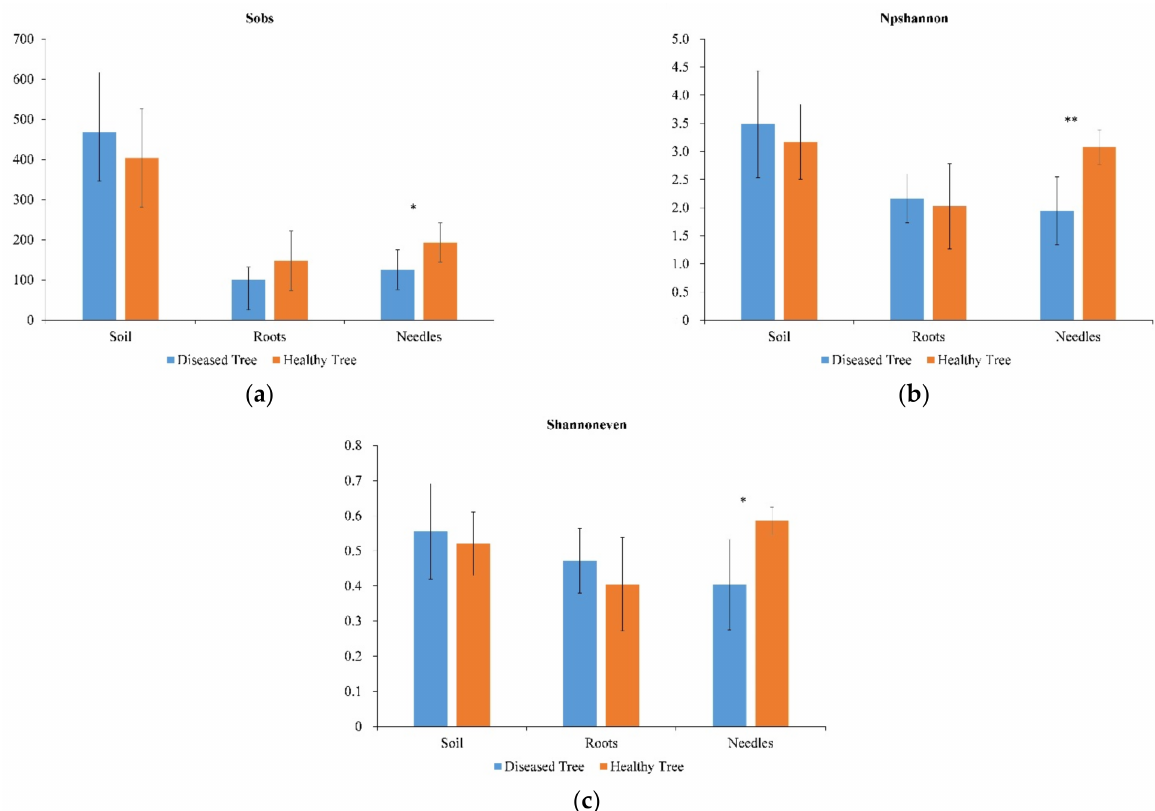
Figure 1. Diversity indices of fungal community in soil, roots, and needles around and of healthy and diseased trees. ( a ) Species richness, ( b ) Shannon α diversity, and ( c ) Shannon evenness. Values show mean with standard deviation ( n = 9, except n = 27 for soil); * p < 0.05 and ** p <